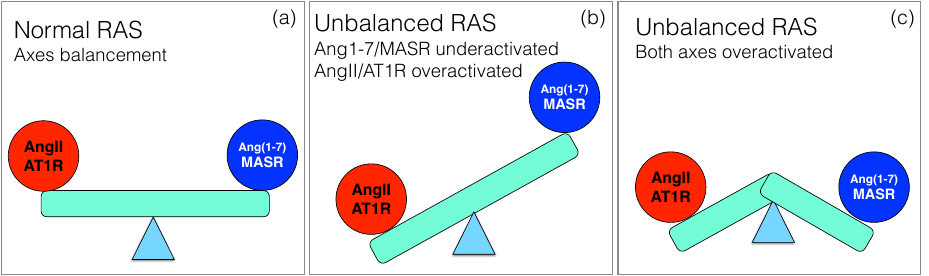
Figure 2. Schematic representation of the two main RAS axes ACE/AngII/AT1R and ACE2/Ang-(1- 7)/MASR in: ( a ) controls and ( b , c ) CoViD-19 patients with two possible dysregulated RAS